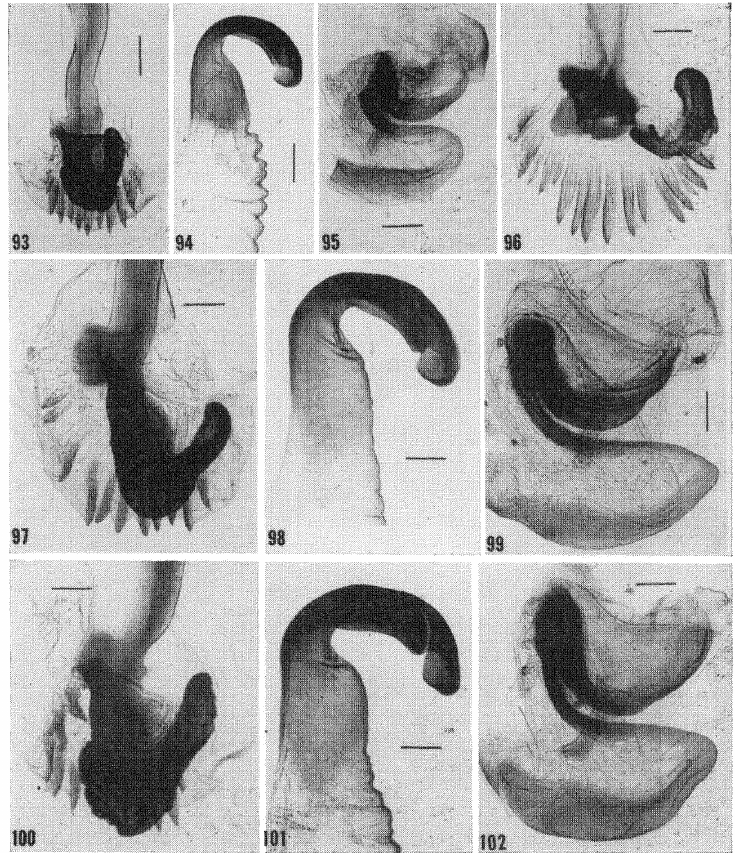
bricosa. (from specimen shown in Fig. 18). 97-99. (15 ANSP). lsli- duchus borinquen. (from specimen shown in Fig. 22). 100-102. (16 ANSP). lsliduchus ca,ernicola. (from specimen shown in Fig. 21). (scale 0.3